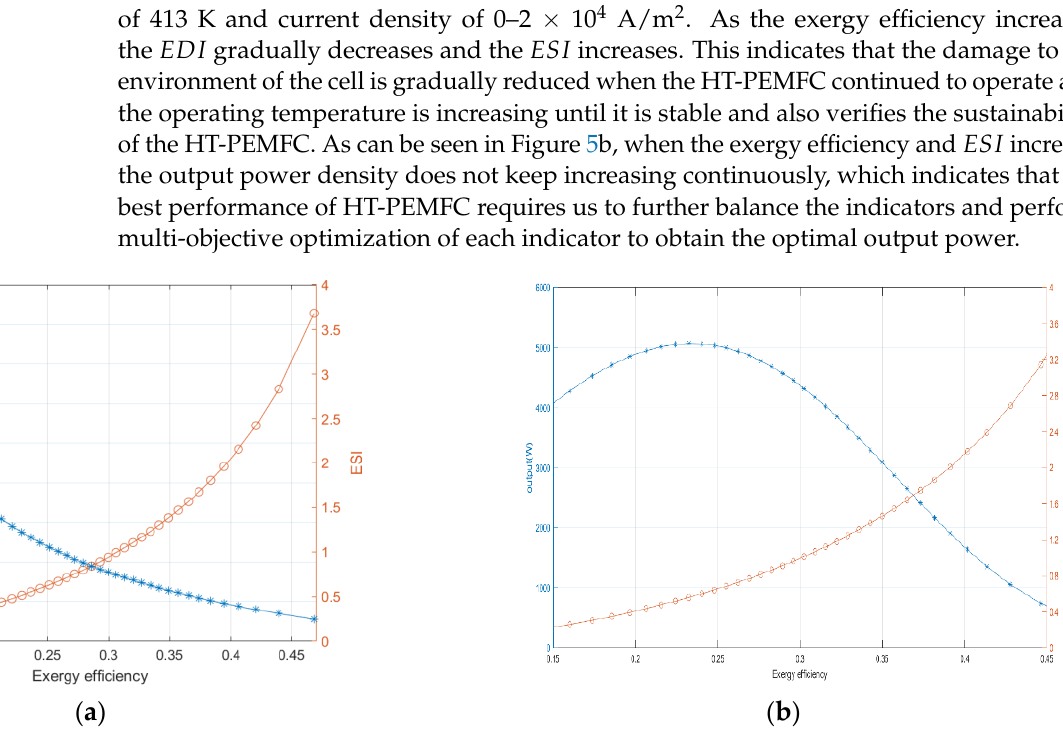
Figure 5. ( a ) Relationship between 𝐸𝑆𝐼 and 𝐸𝐷𝐼 at different exergy efficiency; ( b ) Relationship between 𝐸𝑆𝐼 and 𝑃 at different exergy efficiency.